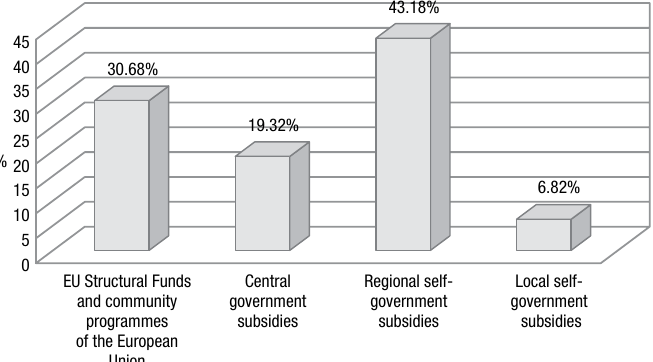
Fig. 2. Percentage of public funds in the cluster budgets in the countries of innovation